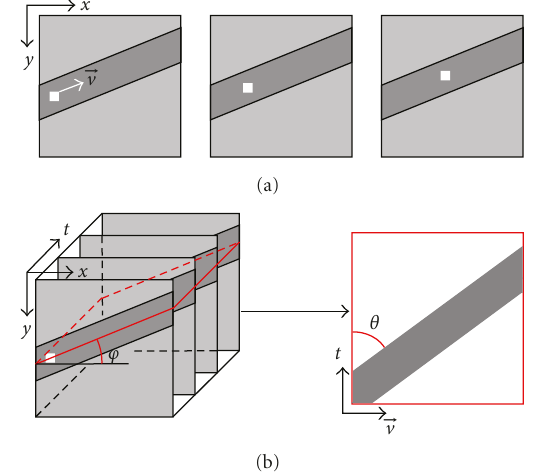
Figure 2: (a) Synthetic image sequence containing a moving object (white square) within the imaging plane ( x , y ). (b) Representation of the sequence in the spatiotemporal frame of reference and a plane extracted along the velocity vector (cid:2) v and time t